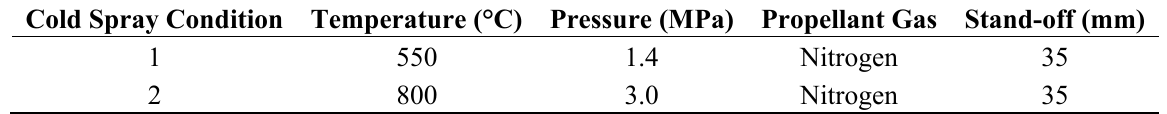
Table 2. Cold Spray conditions for calibration and validation of the developed multicomponent model. Cold Spray Condition